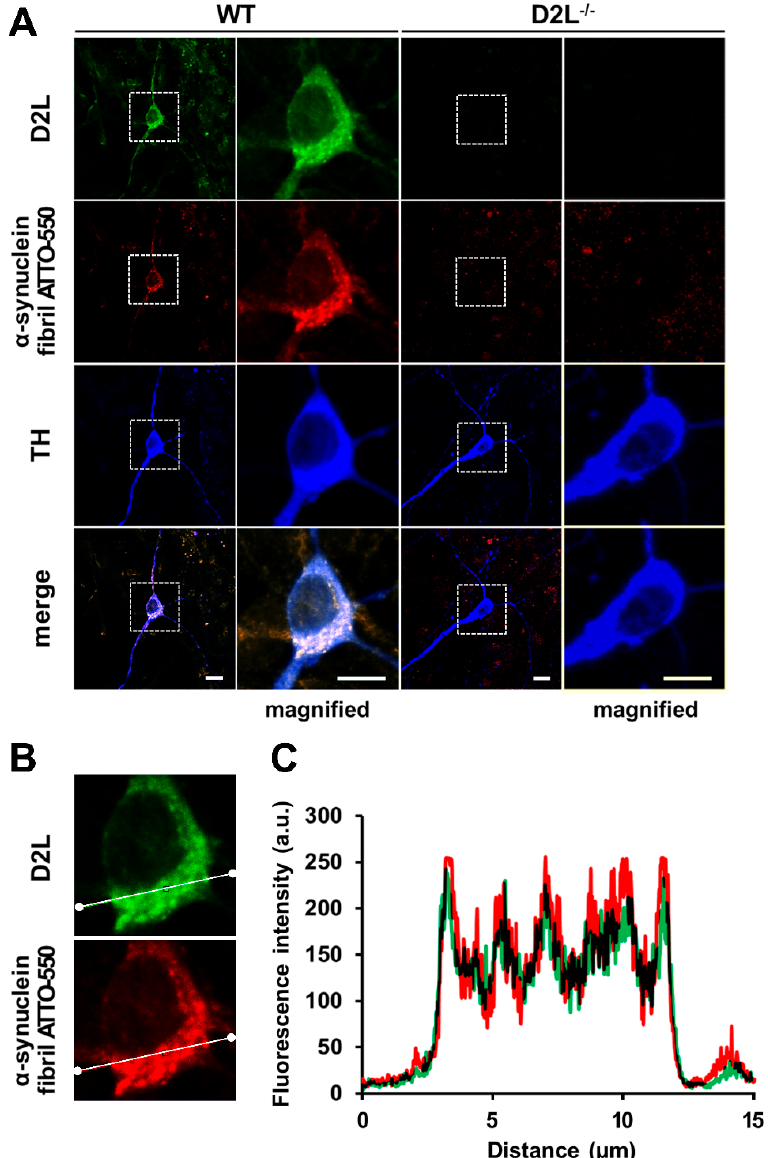
Figure 7. Co-localization of D 2L receptors with α -synuclein fibrils in dopaminergic neurons. ( A ) Cultured mesencephalic neurons were treated with 1 µ M α -synuclein fibril ATTO-550 and stained with anti-D 2L (green) and anti-TH (blue) antibodies. The magnified images were enlarged by three times. Scale bar 10 µ m. ( B ) Z-dimension analysis of D 2L receptor-positive dotted immunoreactivities and α -synuclein fibrils. ( C ) Quantified fluorescence intensities of D 2L receptors and α -synuclein fibrils analyzed in ( B ). Both signals were tightly